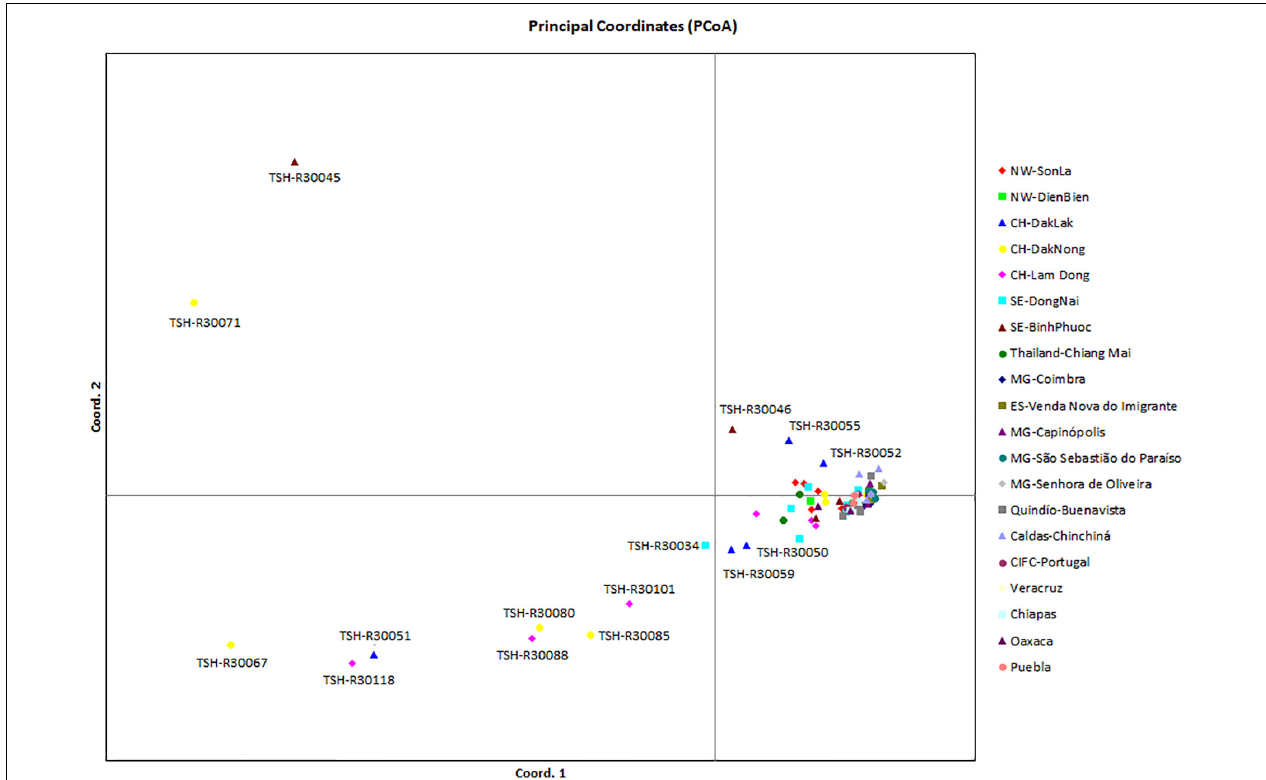
FIGURE 3 | Principal coordinate analysis (PCoA) of the genetic (nucleotide) diversity of Hemileia vastatrix in Vietnam, Thailand, Portugal, and some countries in the Americas (Brazil, Colombia, Mexico). Individuals that are closer together have smaller genetic distances. NW: Northwest (Vietnam), CH: Central Highands (Vietnam), ST: Southeast (Vietnam), CIFC: Centro de Investigação de Ferrugens do Cafeeiro (Portugal), MG: Minas Gerais (Brazil), ES: Espírito Santo (Brazil).